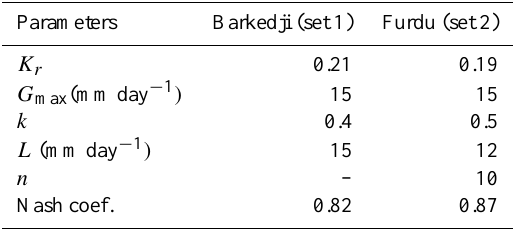
Table 4. Model parameters values resulting from the calibration phase. Parameters Barkedji (set 1)